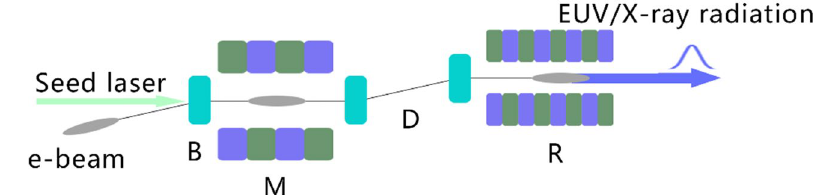
Figure 4. Schematic layout of the ADM scheme.